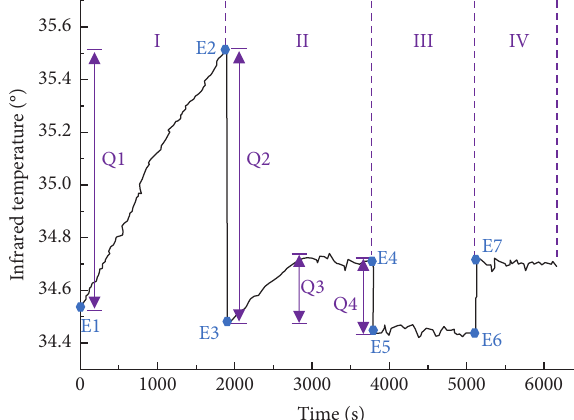
Figure 20: Infrared temperature curves vs time.